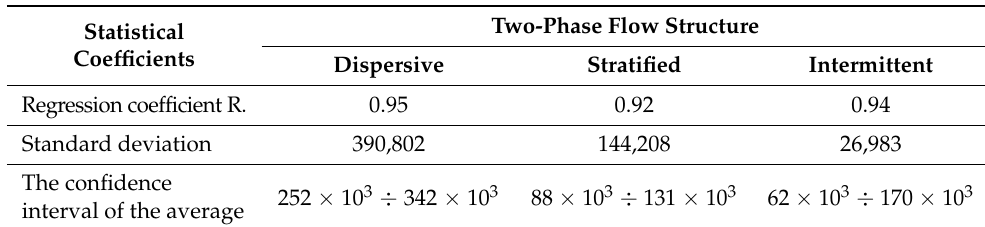
Table 7. Statistical coefficients determined for the model for determining the two-phase flow re- sistance according to the Equations (5) and (6).